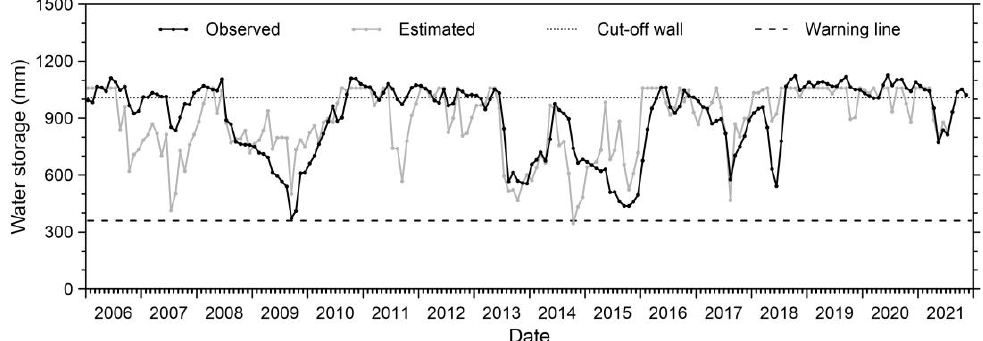
Figure 8. Comparison of estimated and observed water storage for the surface dam under the investigated period.